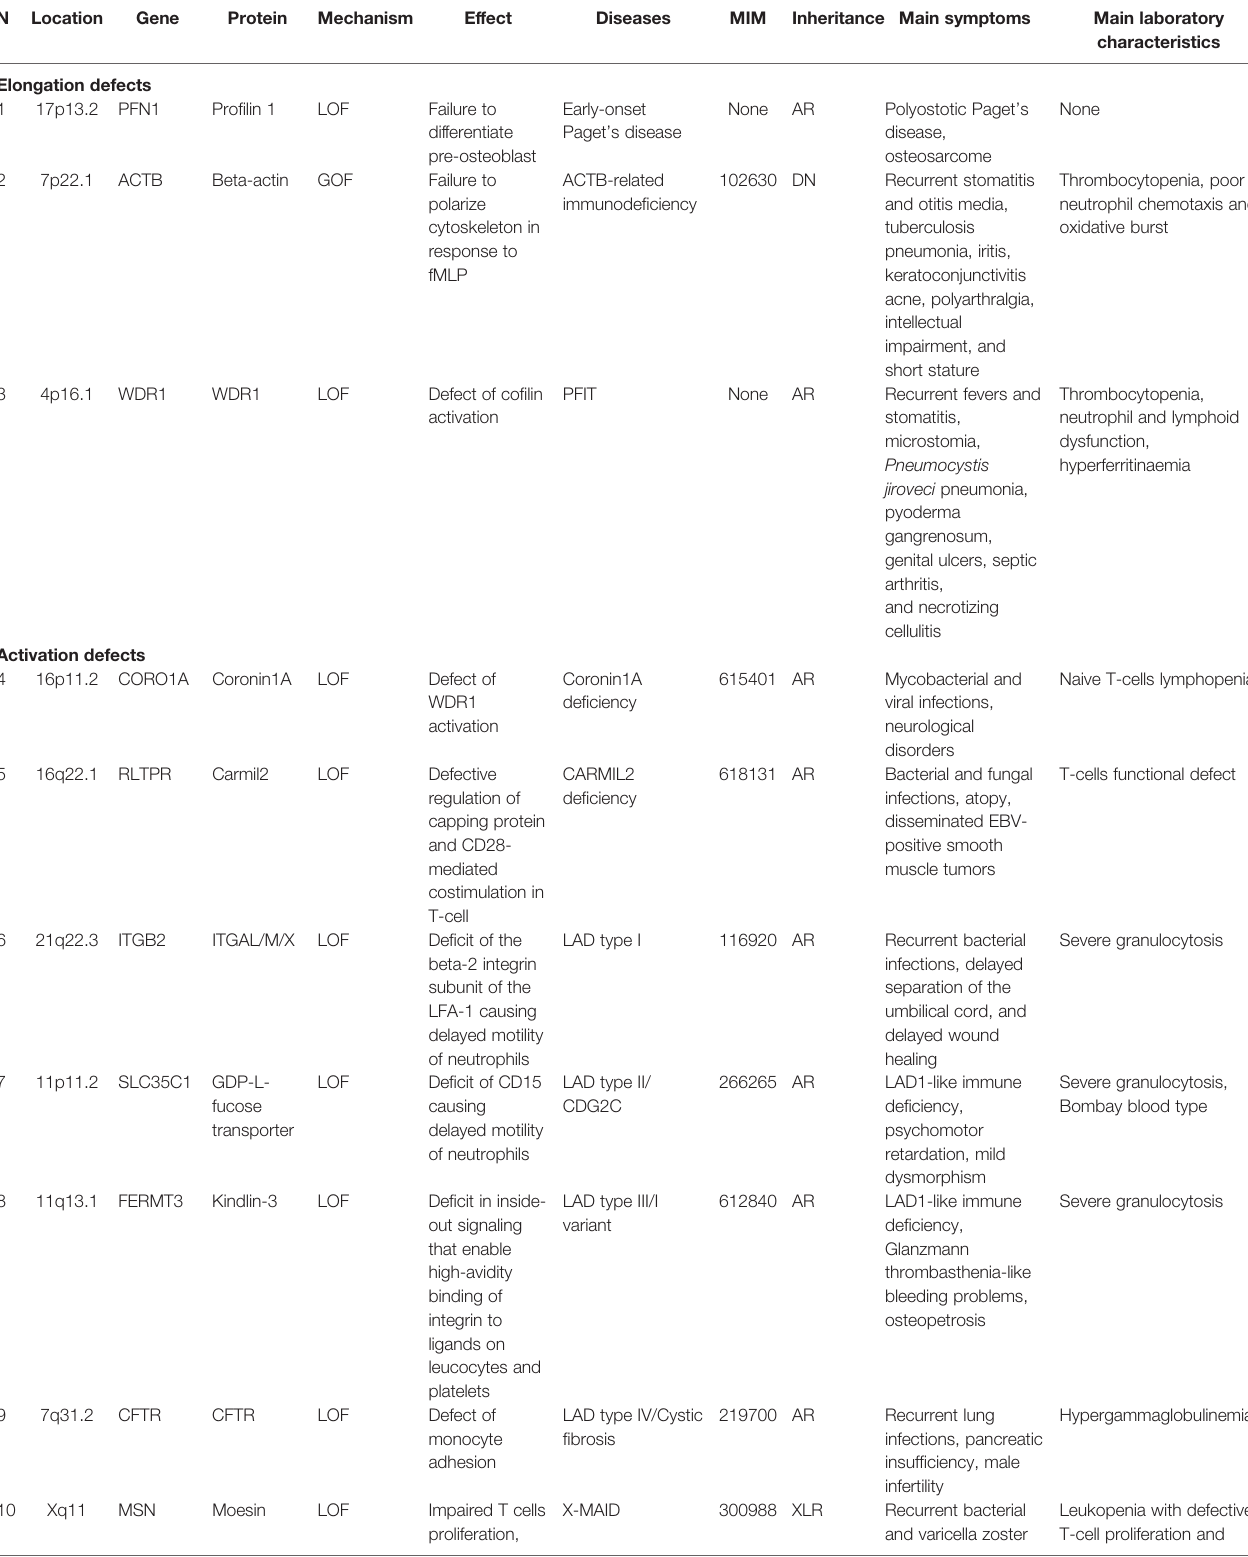
TABLE 1 | Monogenic immune system diseases characterized by actin remodeling